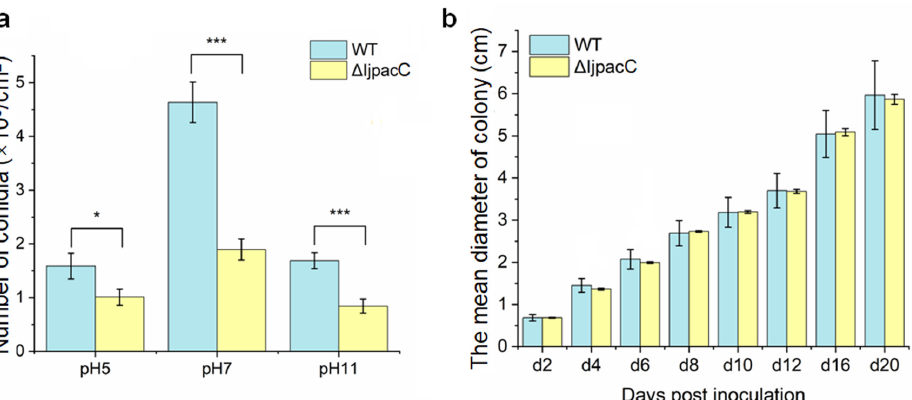
Figure 3. Comparison of conidial production and hyphal growth between the Δ IjpacC mutant and the wild-type strains. ( a ) Conidiation under different pH conditions. ( b ) Vegetative growth under neutral condition (pH7). Fungal strains were cultured on PDA at 25 °C for 7 days. Error bar represents the standard error of the mean. Asterisk marker represents significant difference at a statistical level, (*) p < 0.05, (***) p < 0.001.